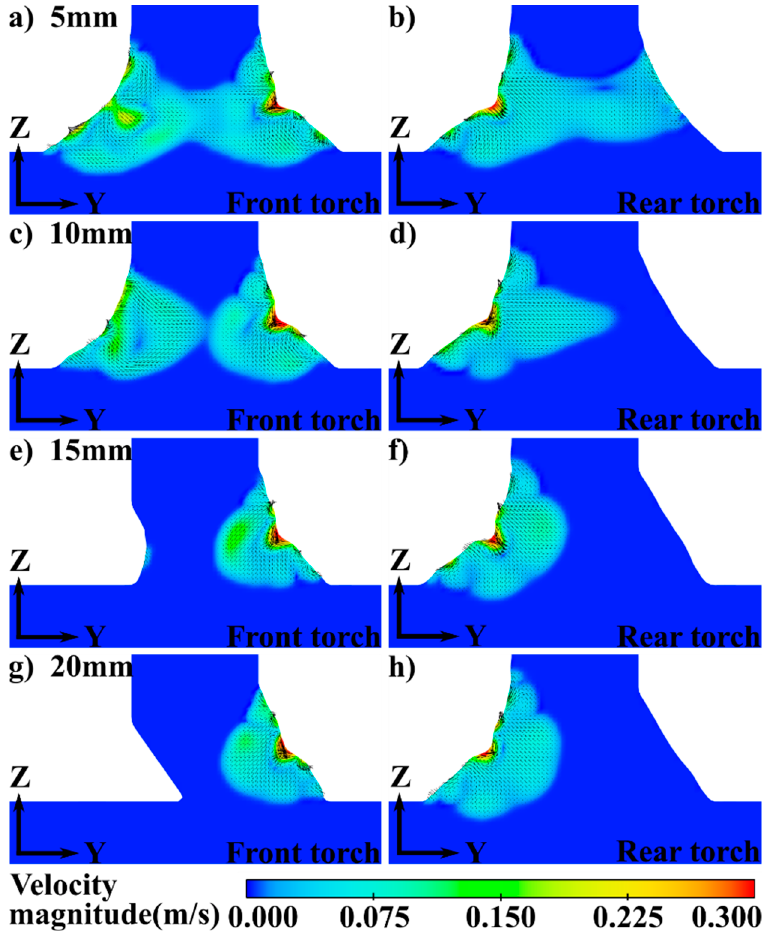
Figure 12. Velocity distribution and velocity vectors on the cross-sections: ( a ) 5 mm front torch, ( b ) 5 mm rear torch, ( c ) 10 mm front torch, ( d ) 10 mm rear torch, ( e ) 15 mm front torch, ( f ) 15 mm-rear torch, ( g ) 20 mm front torch, and ( h ) 20 mm rear torch.